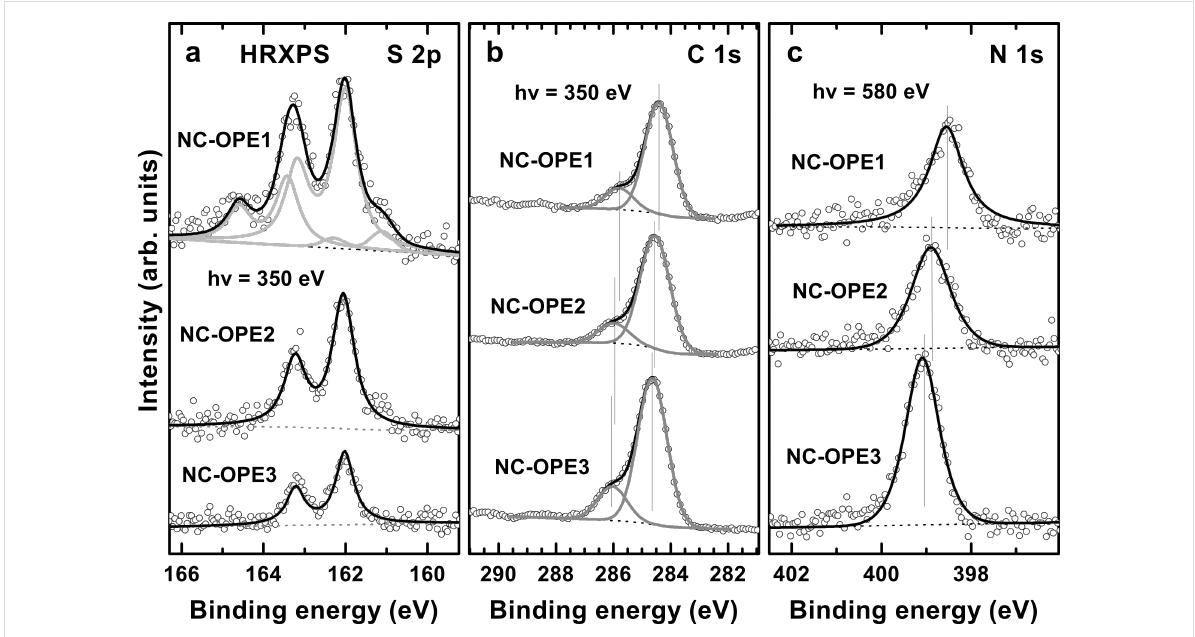
Figure 2: S 2p (a), C 1s (b), and N 1s (c) HRXPS spectra of the target SAMs acquired at photon energies of 350 eV (S 2p and C 1s) and 580 eV (N 1s). Some spectra are decomposed into the individual contributions related to the different species; see text for details. Vertical solid lines mark the positions of the individual emissions in (b) and